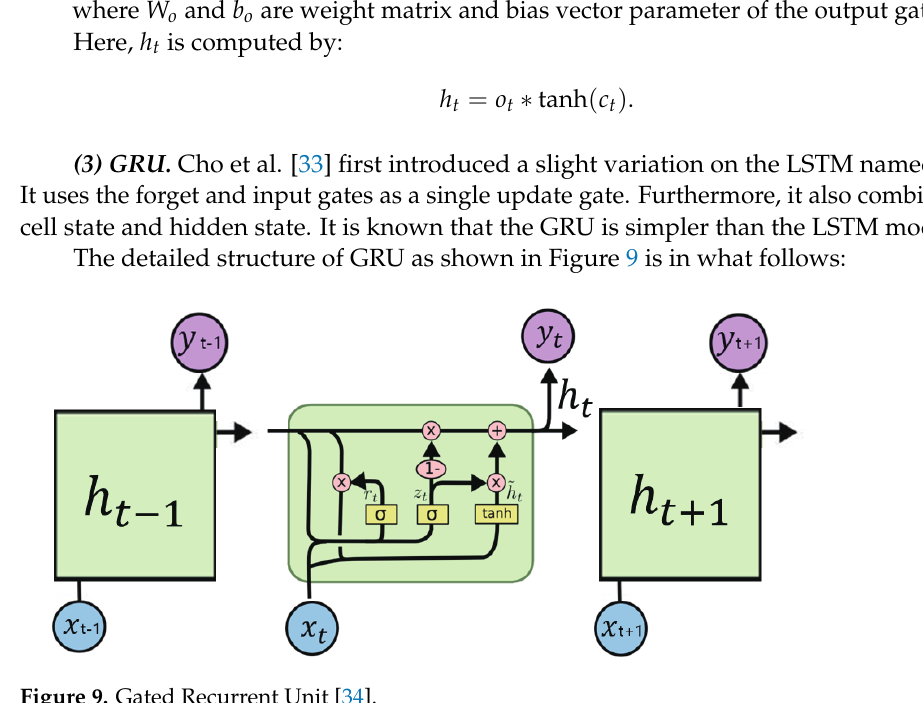
Figure 9. Gated Recurrent Unit